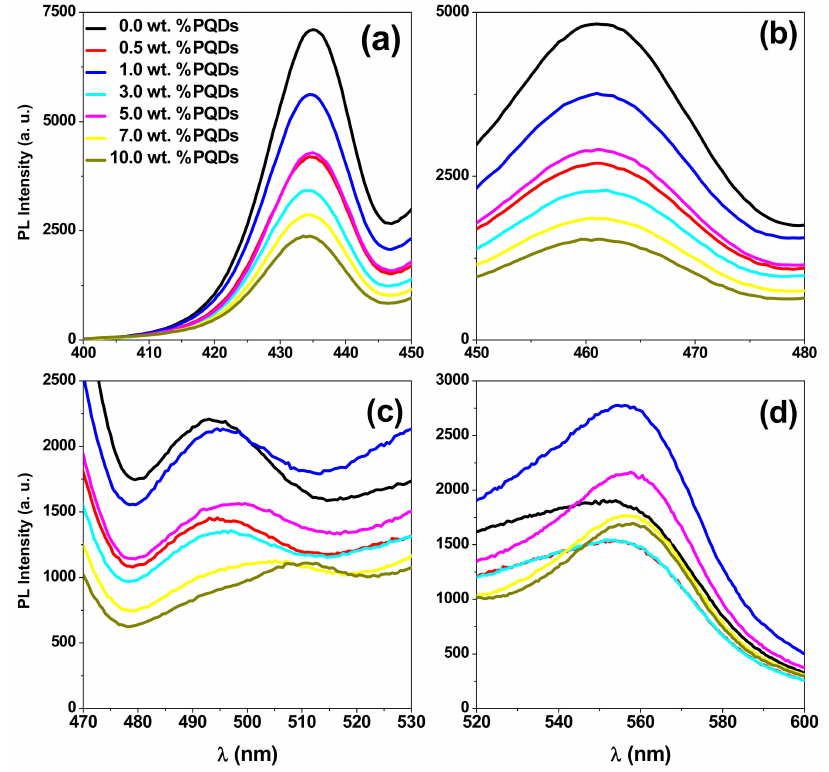
Figure 9. PL spectra of the PQDs/(MEH–PPV/PFO) composite thin films in several ranges ( a – d ) for clarity.